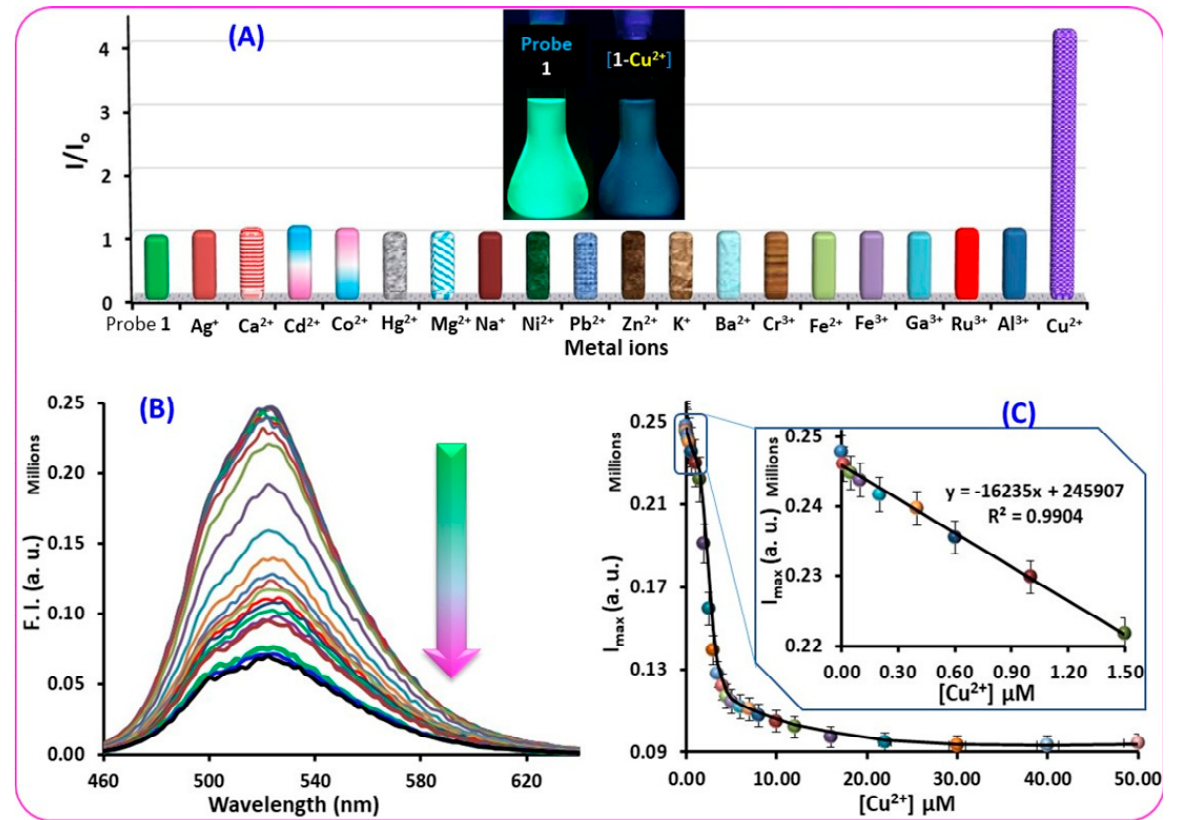
Figure 3. ( A ) Bar diagram of fluorescence intensity ratio ( I o / I ) of probe 1 (10 µM, HEPES (pH 7.4): EtOH = 1:4) upon additions of various metal ions (200 µM each). I o and I are the fluorescence intensities of probe 1 measured at 524 nm before and after additions of the individual metal ions, respectively. The inset shows a luminescence change of the probe solution upon Cu 2+ addition under irradiation at 365 nm. ( B ) Fluorescence titration of the probe with Cu 2+ and ( C ) associated data and fit curve using a fluorescence emission intensity at 524 nm ( I 524 ). The inset shows a linear relationship between [Cu 2+ ] and I max in a low [Cu 2+ ] range (0–1.5 µM); λ ex = 435 nm.